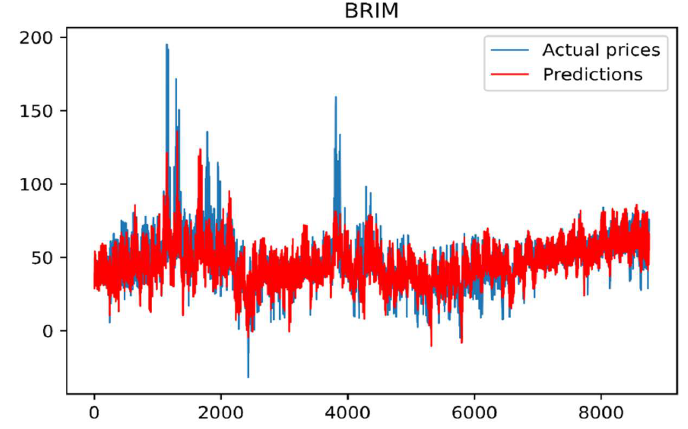
Figure 9. Actual price curve and BRIM prediction curve on the test set.